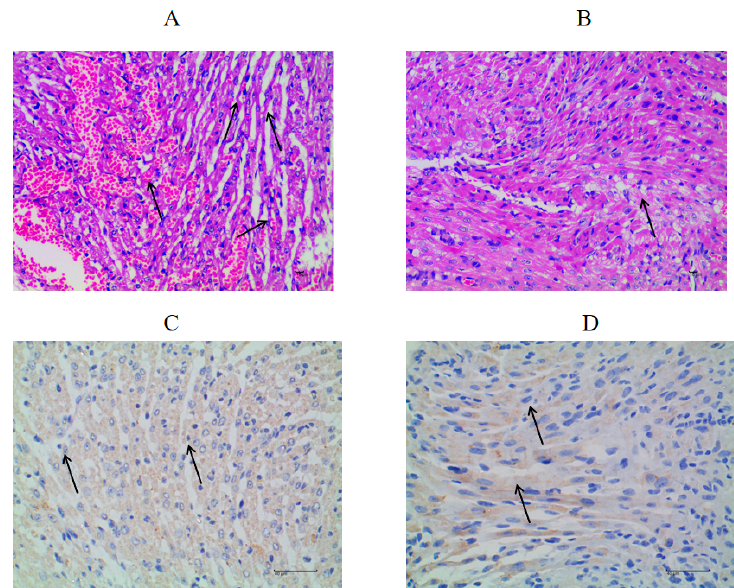
Figure 7. Histological and IHC analysis of heart tissues in FMDV-challenged suckling mice treated with mizoribine at 34 hpi. ( A , B ) The pathological changes of heart tissues were observed after H&E staining. Mice were sacrificed at 34 h post-challenge. Heart tissue were then collected and fixed in 4% paraformaldehyde solution, paraffin embedded, sectioned, and stained with H&E. Representative images from ( A ) control group and ( B ) treated group are shown (N = 4). Tissue damage was identified and is indicated by black arrows (magnification, 400×). ( C , D ) The immunohistochemical expression of FMDV for heart tissue was detected using IHC. Representative images from ( C ) control group and ( D ) treated group are shown (N = 4). FMDV antigen was identified and is indicated by black arrows (magnification, 400×).